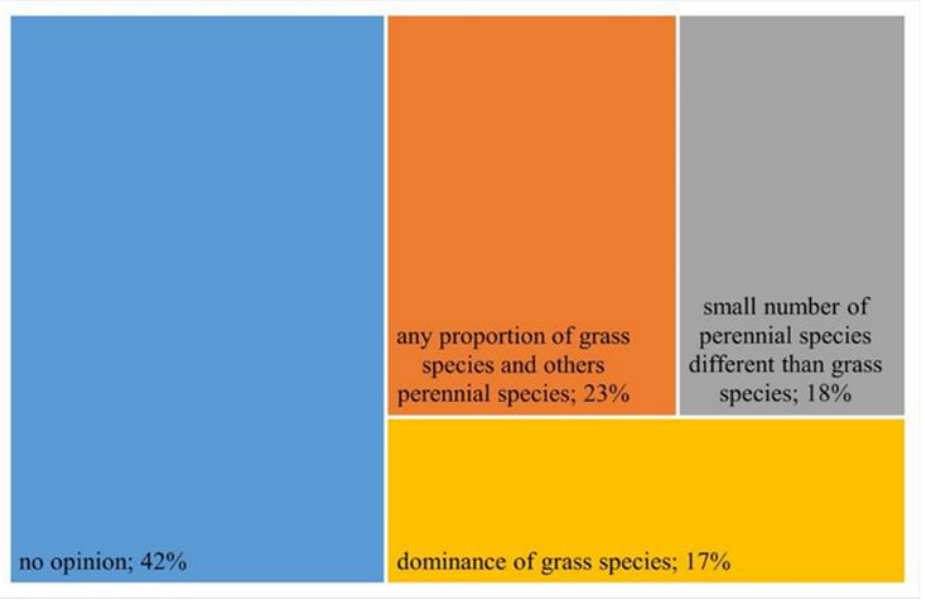
Figure 4. Composition of the lawn species expected by the respondents. The area assigned to each answer is proportional to the total number of responses.